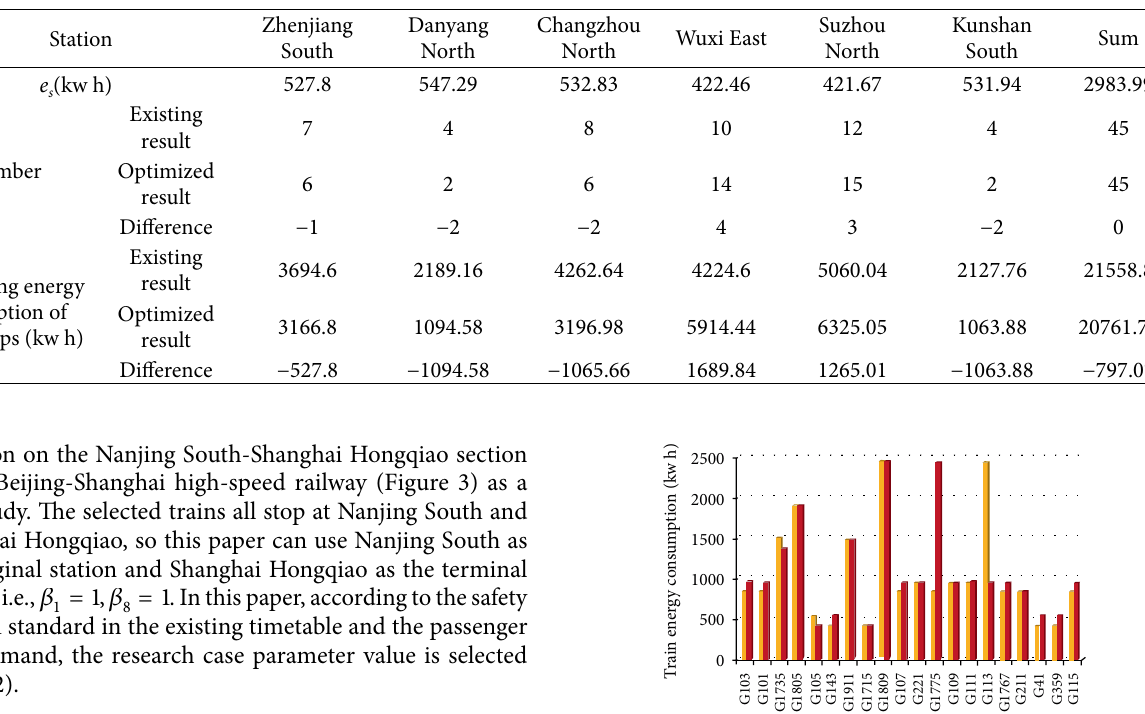
Table 4: Comparisons on the energy consumption of each station.